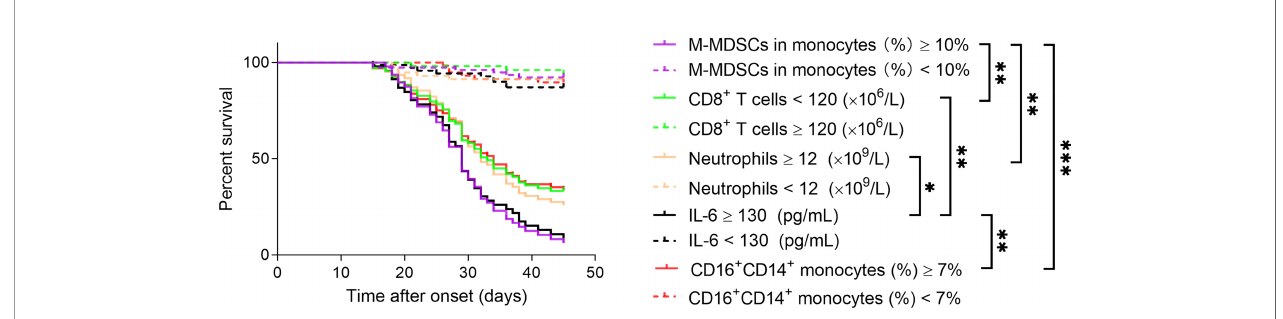
FIGURE 3 | Using immune parameters for predicting COVID-19 mortality. The effect of immune parameters including M-MDSCs, CD8 + T cells, neutrophils, IL-6, and CD16 + CD14 + monocytes on predicting 45-day mortality after onset of illness was analyzed in COVID-19 patients. M-MDSCs, monocytic-myeloid-derived suppressor cells. * p < 0.05, ** p < 0.01, *** p